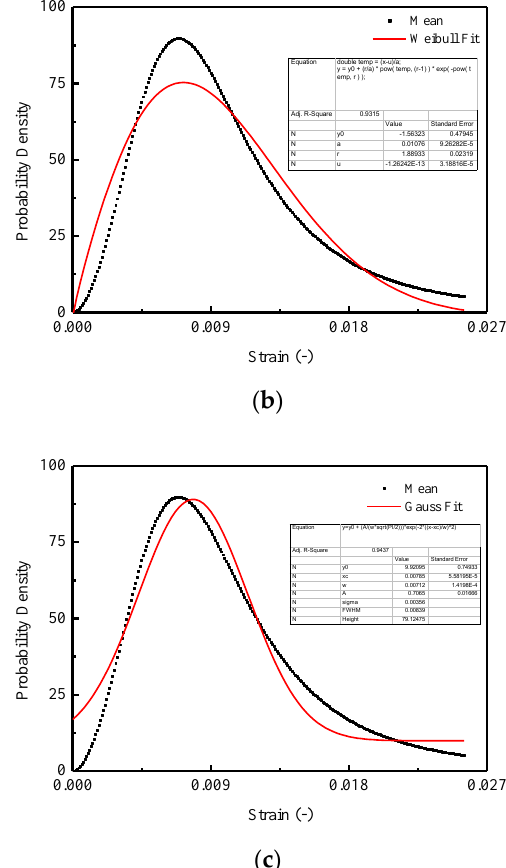
Figure 15. Fitting of the probability density for the thresholds: ( a ) Lognormal distribution; ( b ) Weibull distribution; ( c ) Gauss distribution.